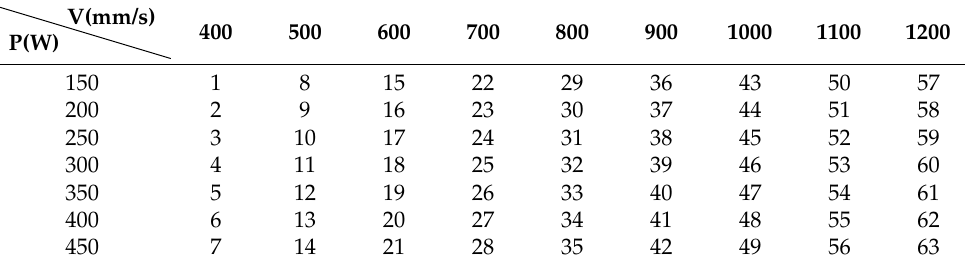
Table 5. Parameters of the first orthogonal test.